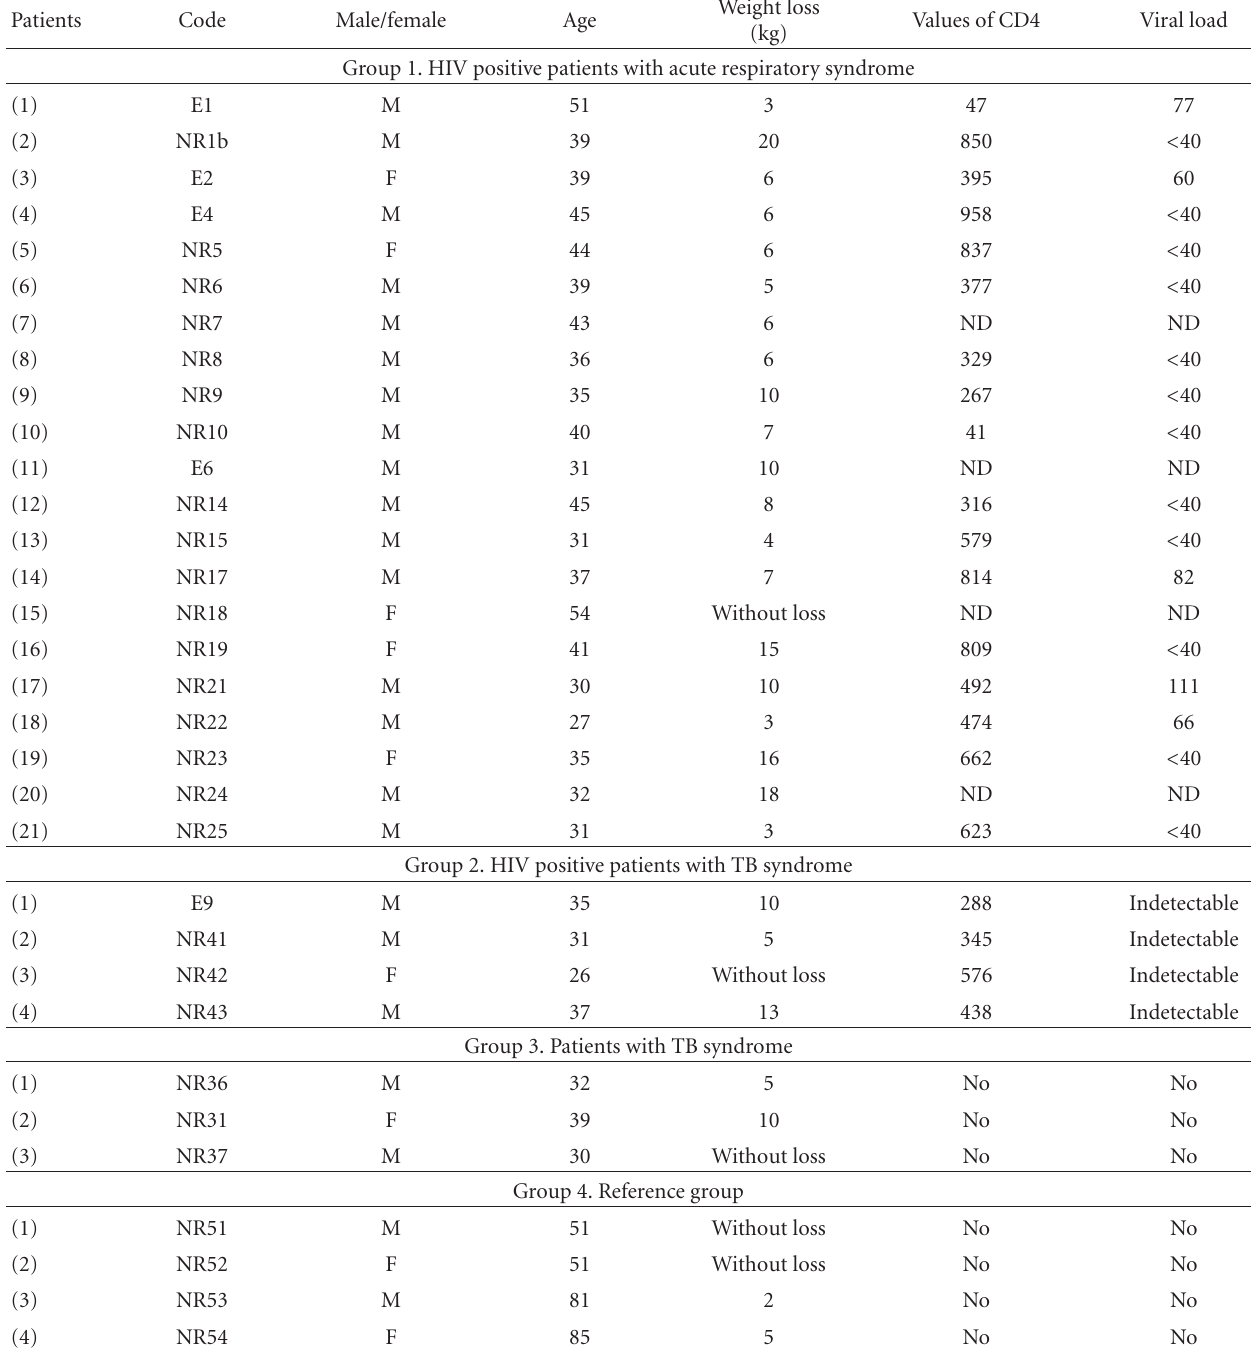
Table 1: Demographic characteristics of the patients, CD4 values and viral